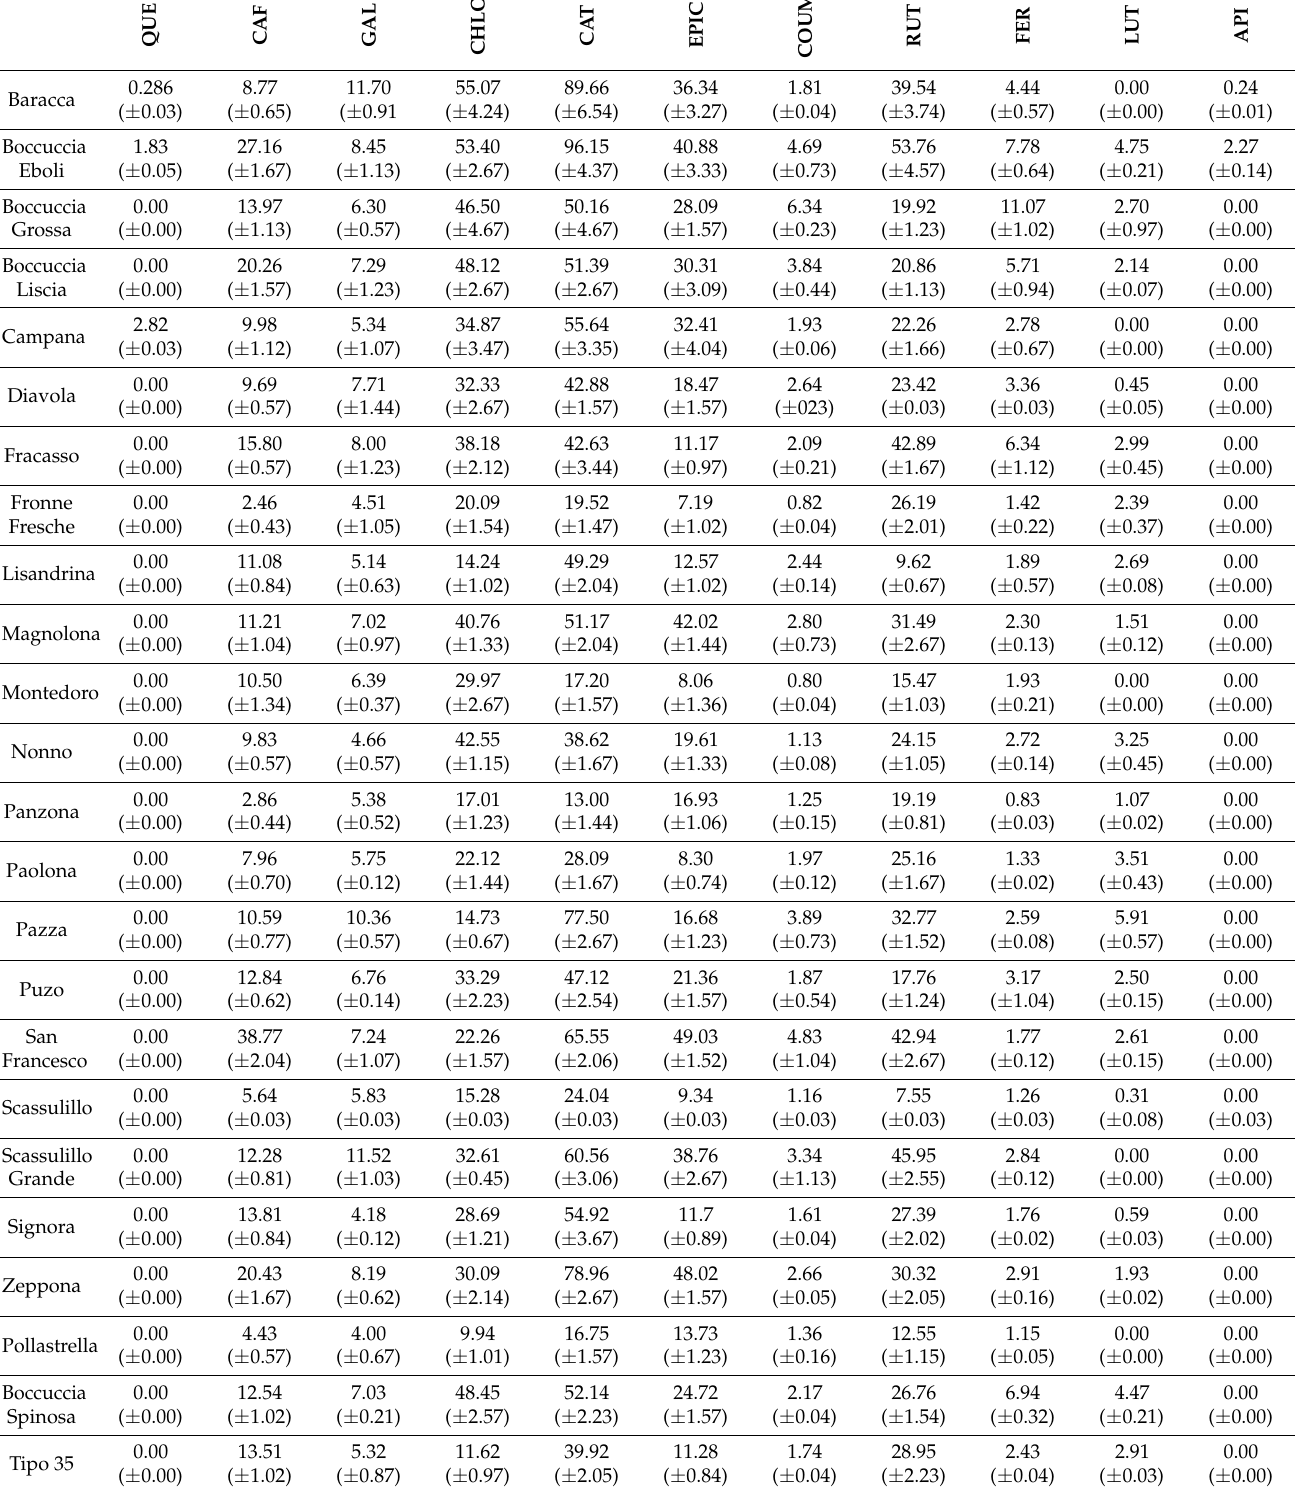
Table 2. Amount of polyphenols known present in the varieties of Campania apricots, detected by UPLC-DAD. Data are reported as µ g g − 1 of fresh product and are mean values ± SD of three determinations. QUE: quercetin; CAF: caffeic acid; GAL: gallic acid; CHLO: chlorogenic acid; CAT: catechin; EPIC:e picatechin; COUM: p -coumaric acid; RUT: rutin; FER: ferulic acid; LUT: luteolin; API: